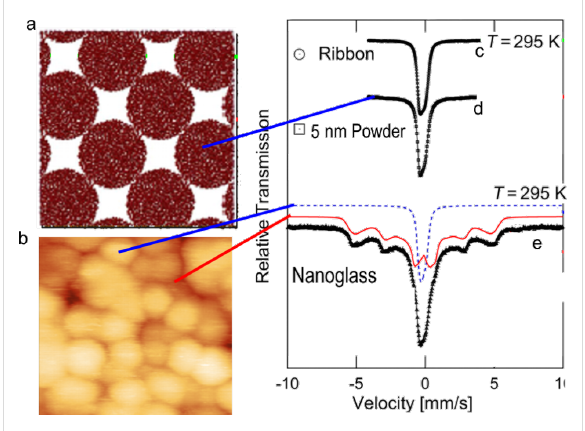
Figure 2: (a) As-quenched (from the vapor phase) nanoglassy grains exhibiting paramagnetic behavior, and (b) quenched from vapor phase and compacted nanoglass, in which the interface matter exhibits ferro- magnetic behavior. Adapted from [15]. Copyright 2013 American Insti- tute of